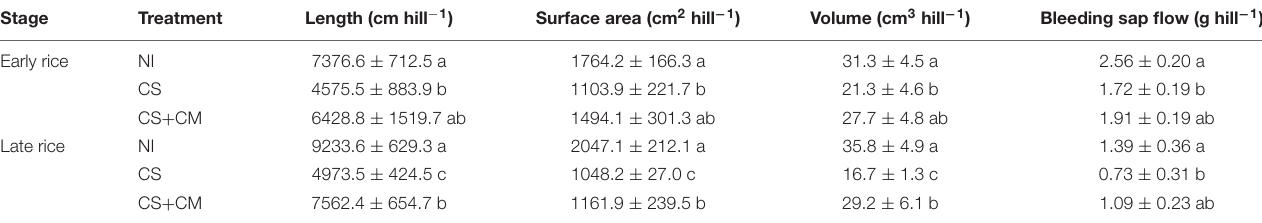
TABLE 1 | Morphology and vitality of rice roots at harvest stage under different treatments in field experiment.